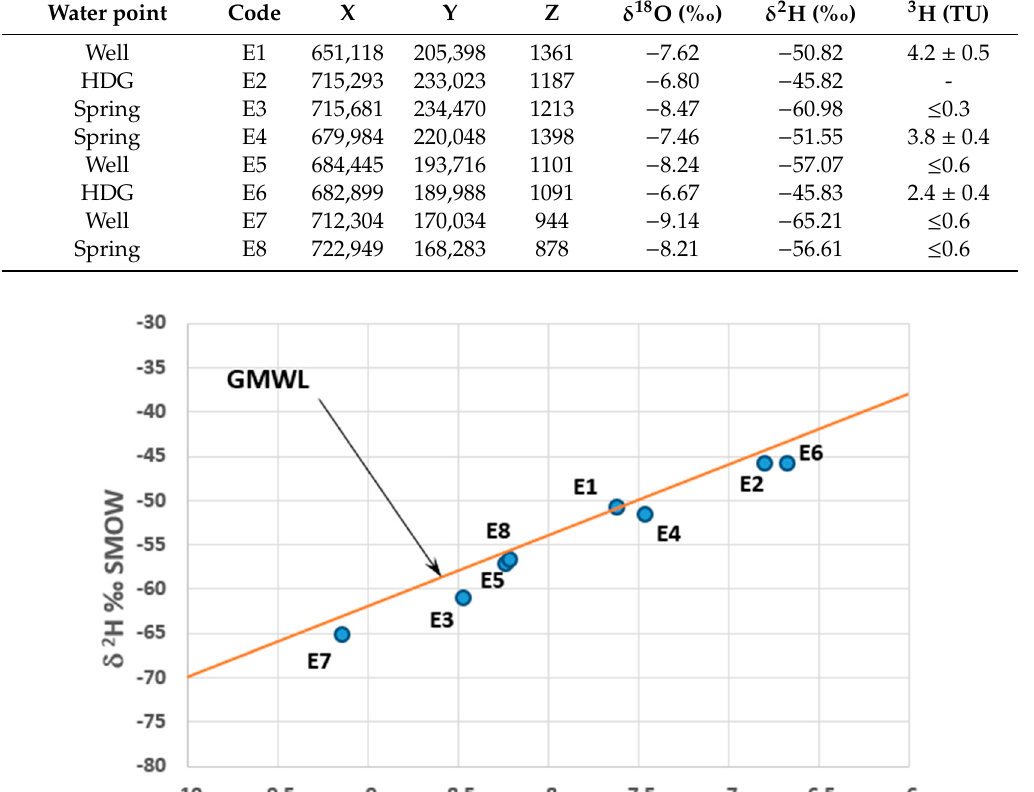
Table 5. Groundwater stable isotope data.